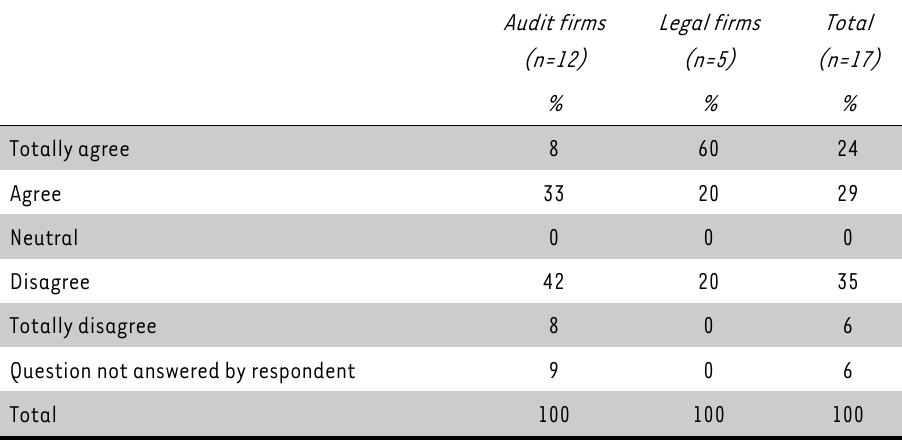
TABLE 12 Results of Question